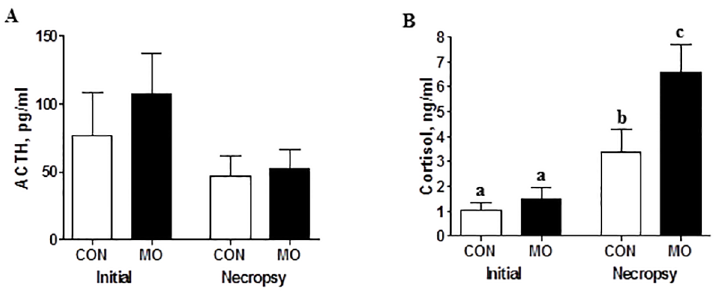
Fig 1. Plasma ACTH (A) and cortisol (B) levels of CON (open bars; n = 6) and MO (solid bars; n = 6) adult male F1 offspring at the initiation and the end of the feeding trial. a,b,c Means ± SEM with different superscripts differ, ( P < 0.05).